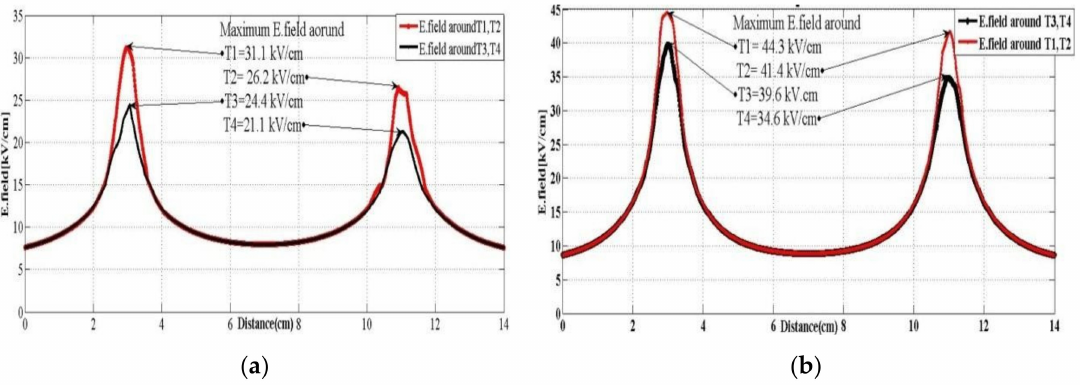
Figure 12. Electric field plot on an Square-shape geometrical structure with upward leader ( a ) and without upward leaders’ inception ( b ).